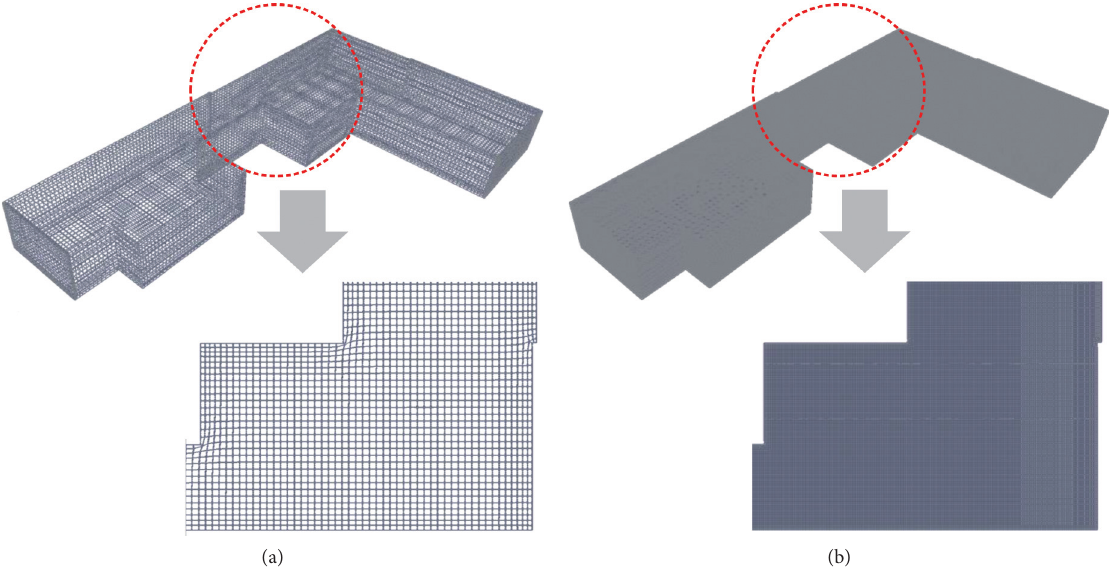
Figure 3: Grid diagrammatic sketch by grid resolution (E type). (a) Resolution 4. (b) Resolution 24.